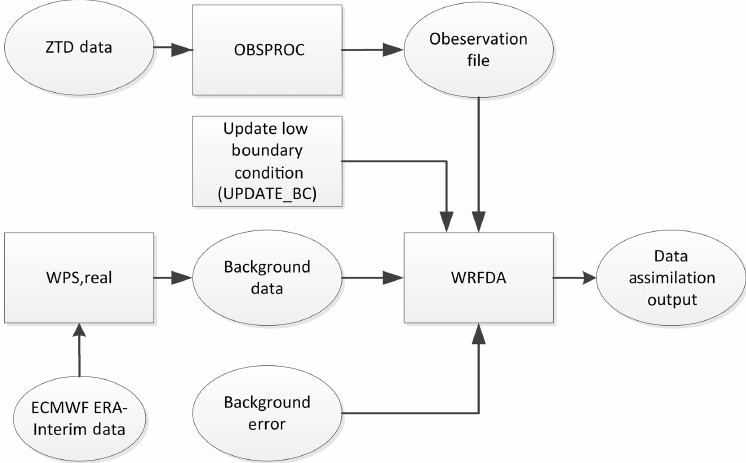
Figure 2. Flowchart of data assimilation using the WRF model. Table 1. Physical parameterization schemes and statistics of bias, rms, and SD of retrieved WR using different schemes. Unit is mmkm − 1 . PBL